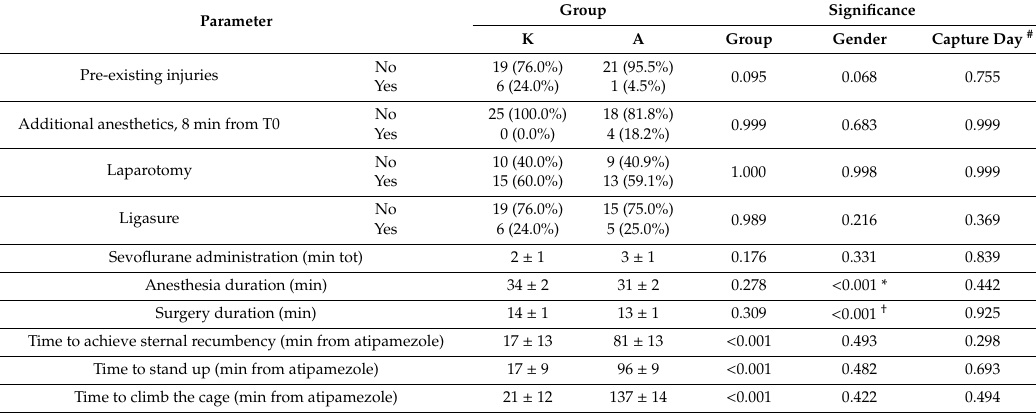
Table 3. Parameters of clinical conditions at arrival, additional anesthetics required according to a Descriptive Scoring System (DSS), procedural characteristics, and recovery times recorded for wild gray squirrels undergoing gonadectomy and randomized to receive two anesthetic mixtures IM: Ketamine-dexmedetomidine-midazolam (group K, n = 25) and alfaxalone-dexmedetomidine-midazolam (group A, n = 22). Values are numbers and percentages or estimated marginal means ± standard error. Group Parameter